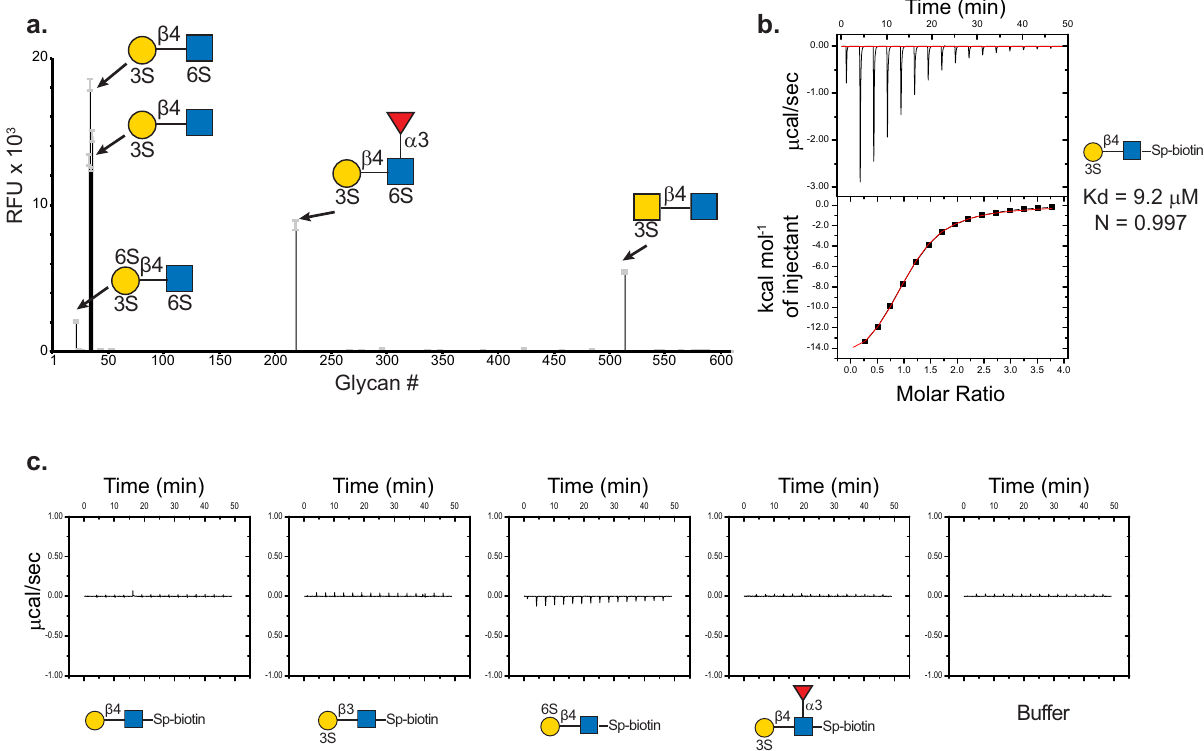
Fig. 1 The speci fi city of VLR O6 as determined by glycan microarray and ITC. a O6-mFc chimeric protein screened on CFG mammalian glycan microarray at 10 µ g/mL reveals the binding motif of O6 is (3 S)Gal β 1-4GlcNAc. RFU relative fl uorescence units, error bars = ±1 SD. b Monomeric VLR O6 binds to ligand with ~10 µ M af fi nity. c No detectable binding curves were observed by ITC for the following structures: Gal β 1-4GlcNAc, (3 S)Gal β 1-3GlcNAc, (6 S) Gal β 1-4GlcNAc and (3 S)Gal β 1-4(Fuc α 1-3)GlcNAc β -Sp. Yellow circle = Gal, yellow square = GalNAc, blue square = GlcNAc, red triangle = fucose, 3 S and 6 S = position of